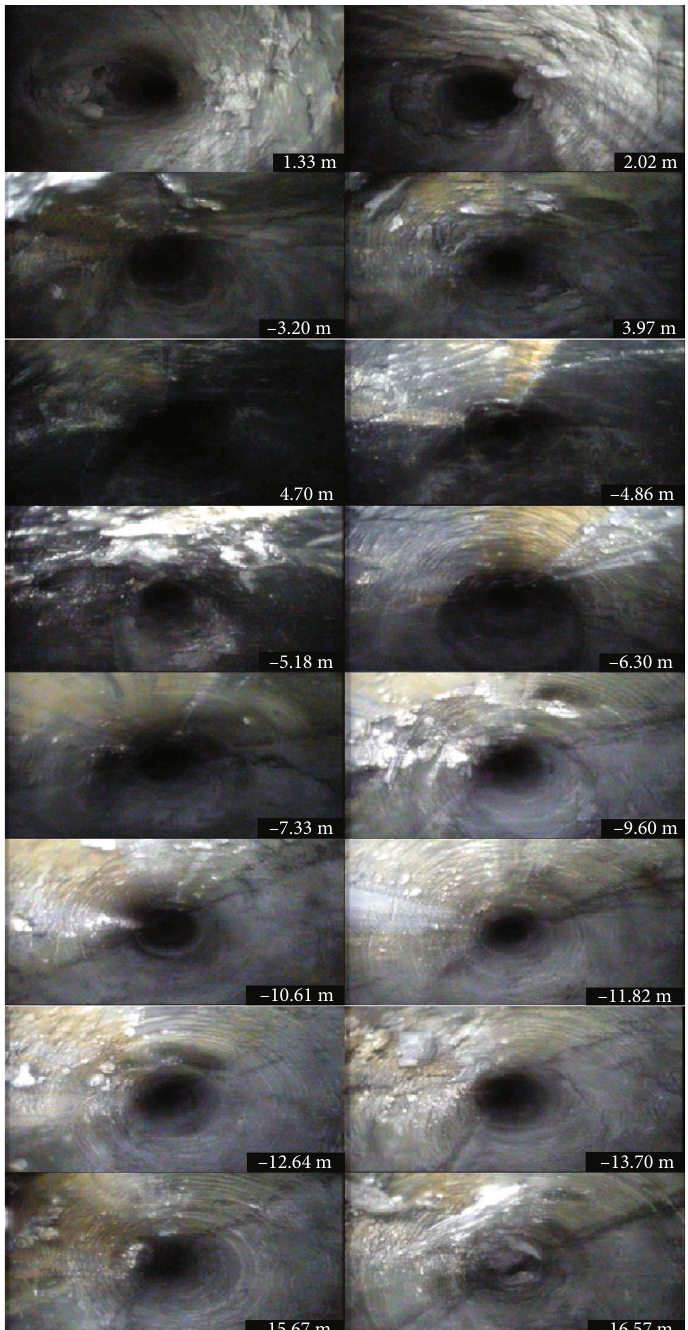
Figure 9: View of C 5a gas drainage borehole in upper adjacent